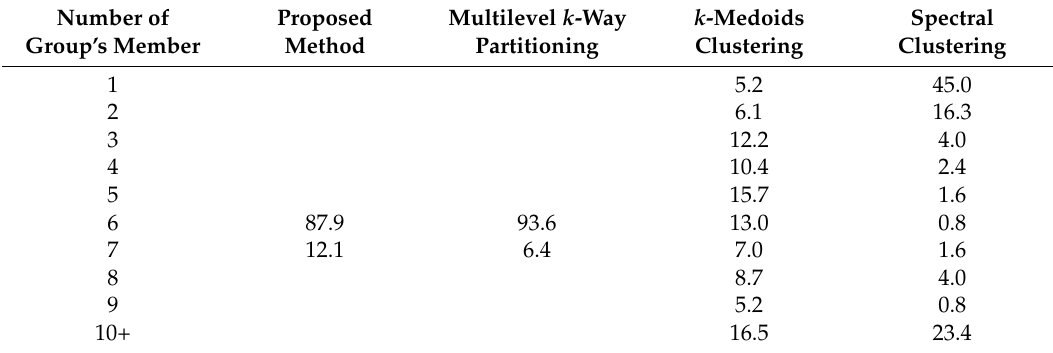
Table 4. The average of Cluster size distribution (per cent) resulting from the proposed and three existing clustering